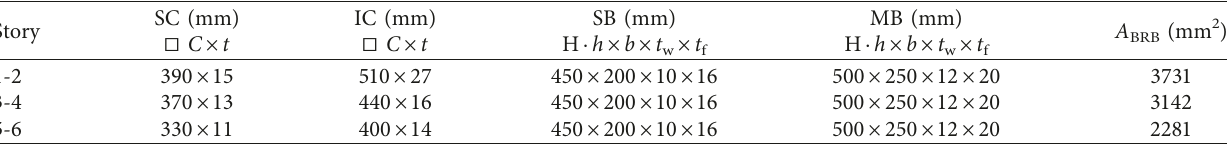
Figure 2: Elevation of the Table 1: Member section of the beam, column, and BRBs of the six-story HPBRBF.